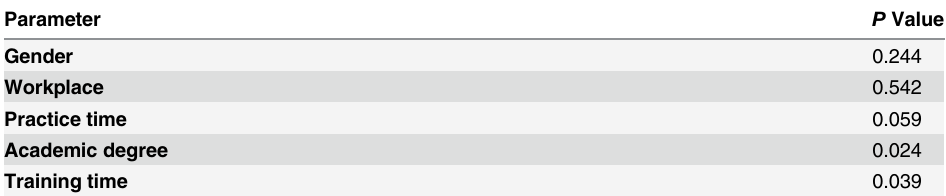
Table 3. Multivariate Logistic Regression Analysis of Potential Limiting Factors Associated with the Capability of Chinese Corneal Specialists to Perform Keratoplasties.